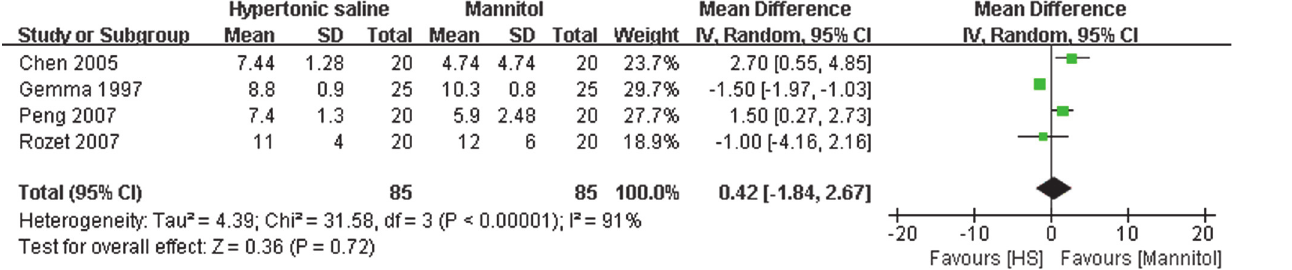
Fig 7. Maximal central venous pressure (CVP) in HS and mannitol groups. IV: Inverse Variance.